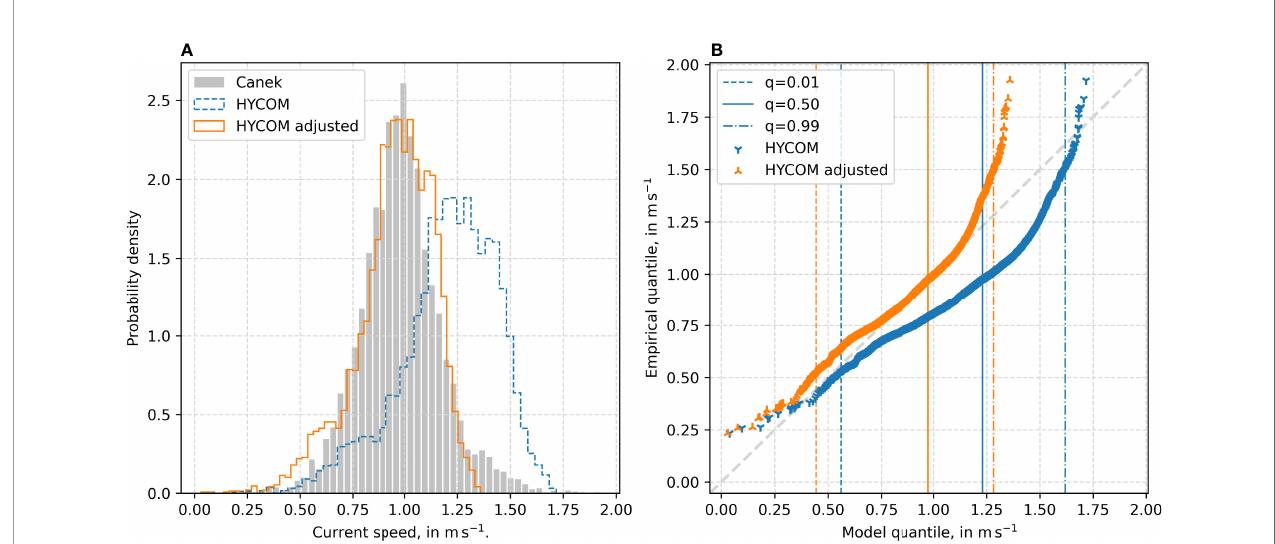
FIGURE 2 | Adjustment of the HYCOM numerical data to the Canek-project empirical data [from the ADCP shown in Figure 1 (B) ]. (A) Histogram showing the numerical data before and after the adjustment. (B) Q-Q plot of numerical data before and after the adjustment. The 0.01 st 0.5 th and 0.99 th -quantiles are marked for both data sets.